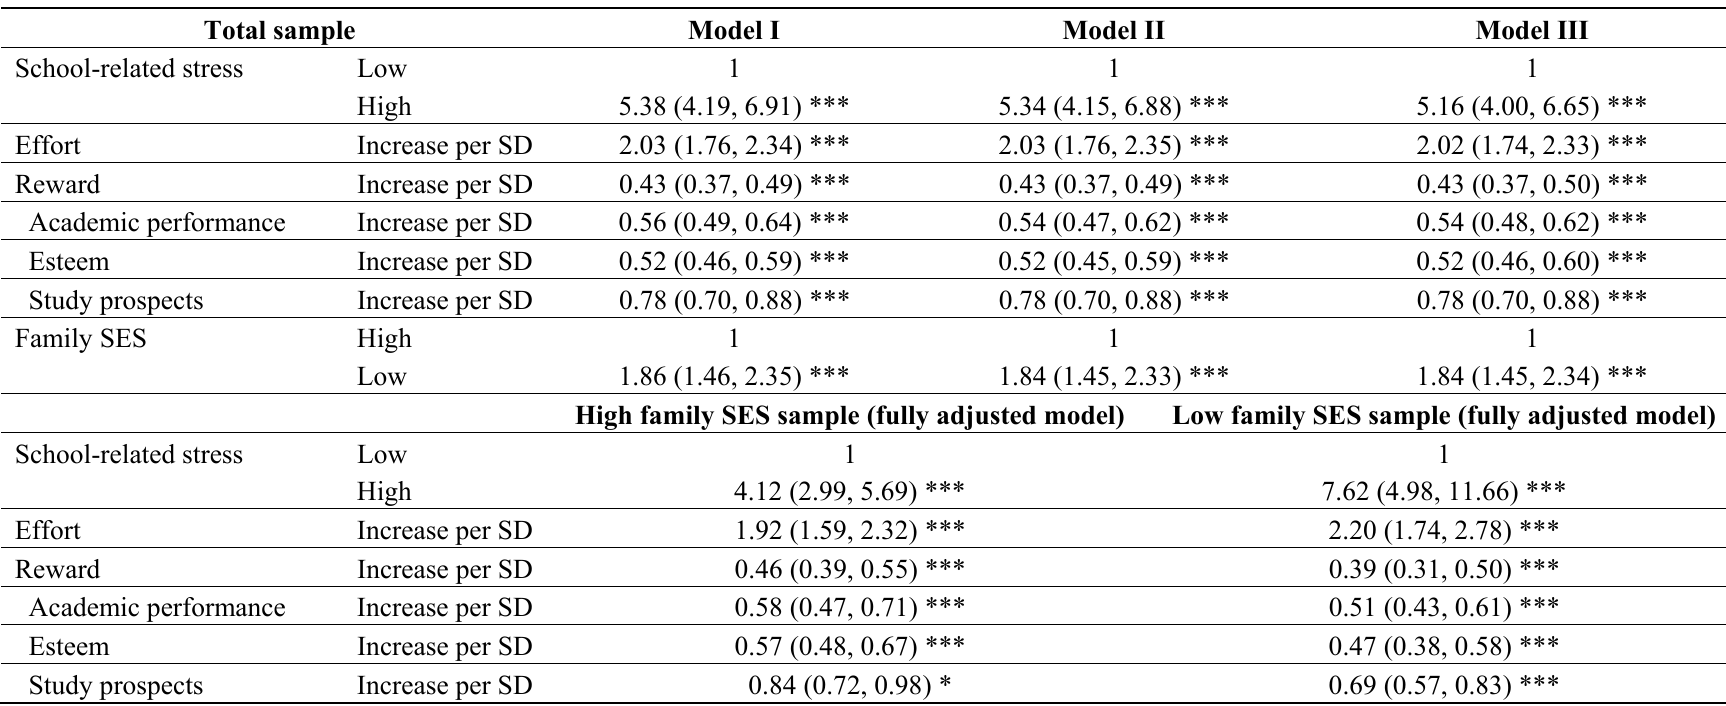
Table 2. Associations of school-related stress and family SES with depressive symptoms (ORs and 95%